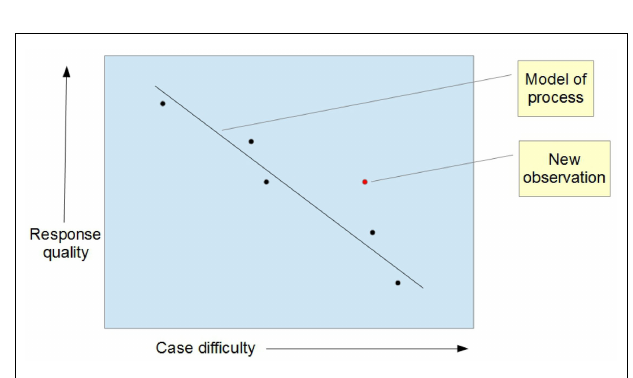
FIGURE 4 | Adding a new point: is it different from the model?